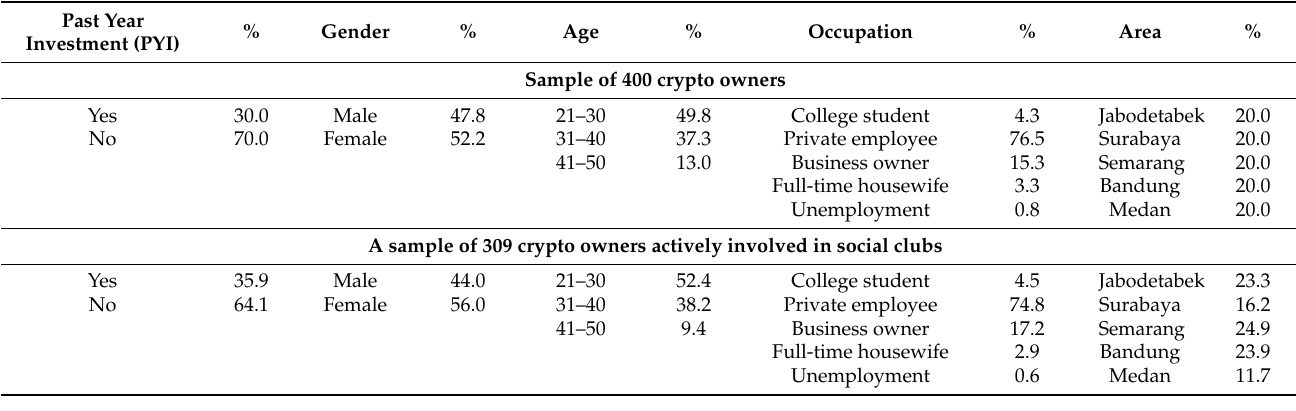
Table 3. Demographics of